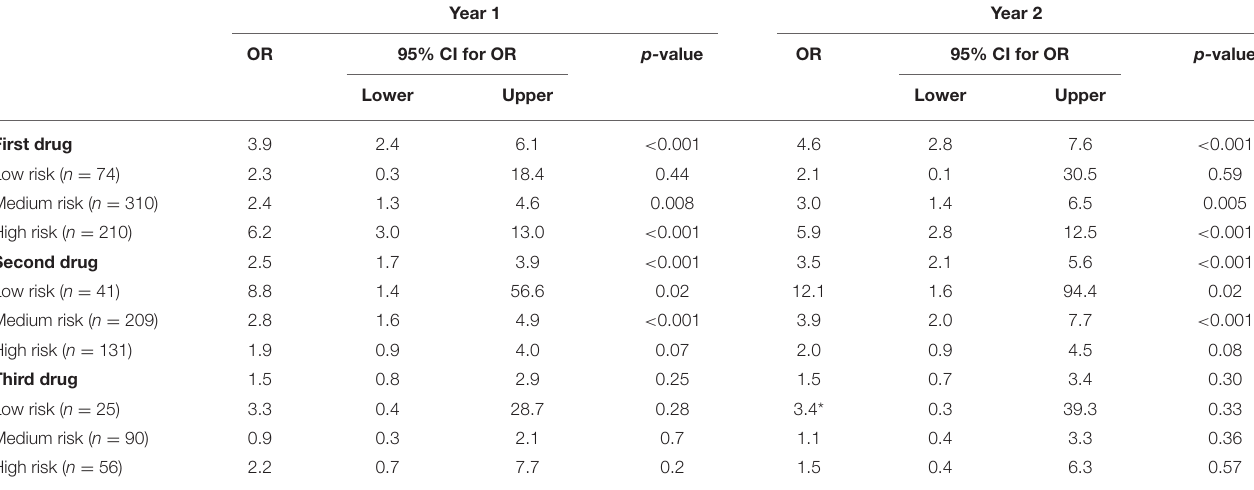
TABLE 5 | Odds ratio (OR) analyzed by binary logistics for NEDA year 1 and 2 in high efficacy DMT vs. moderate efficacy DMT, stratified by risk and adjusted for age at initiation of medication, time from onset to initiation of drug and